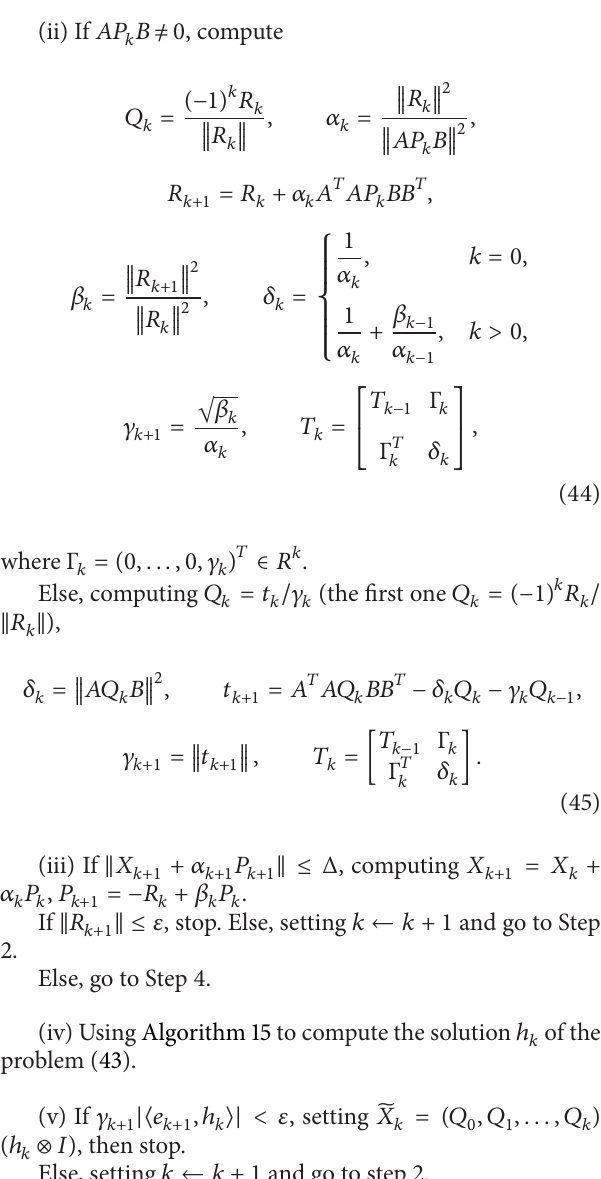
Algorithm 16. (i) Given matrices 𝑋 0 = 0 , 𝑄 −1 = 0 and a